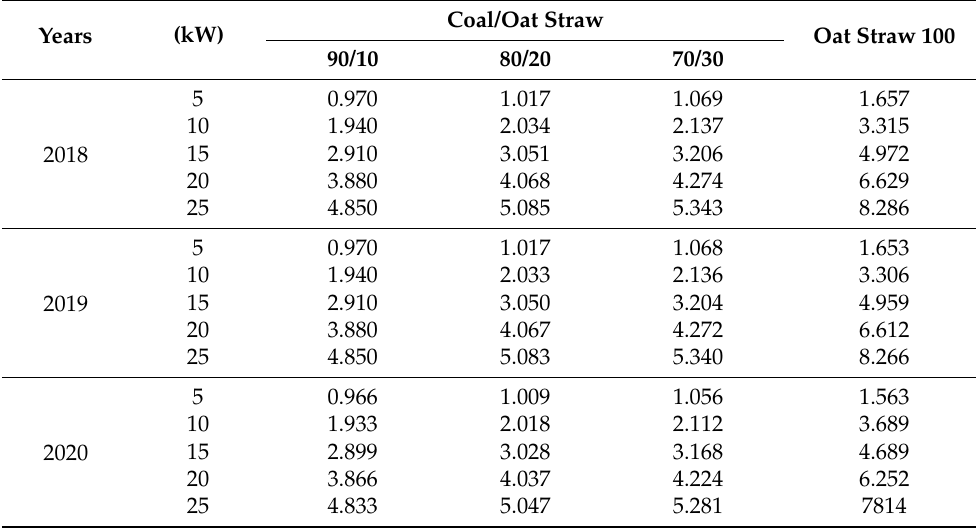
Table 3. Raw material consumption (kg/h) depending on the power of the boiler and the percentage of oat straw.